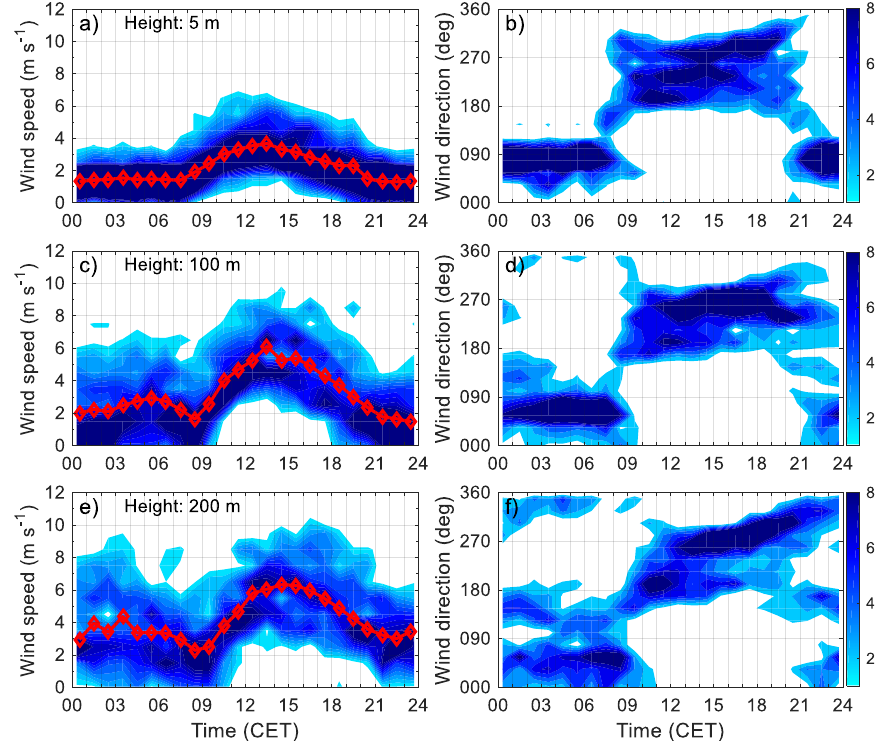
Figure 12. Diurnal behaviour of the wind speed ( a , c , e ) and wind direction ( b , d , f ) for the summer months June–August in 2015 and 2016. Red lines on the wind speed graphs indicate median values.